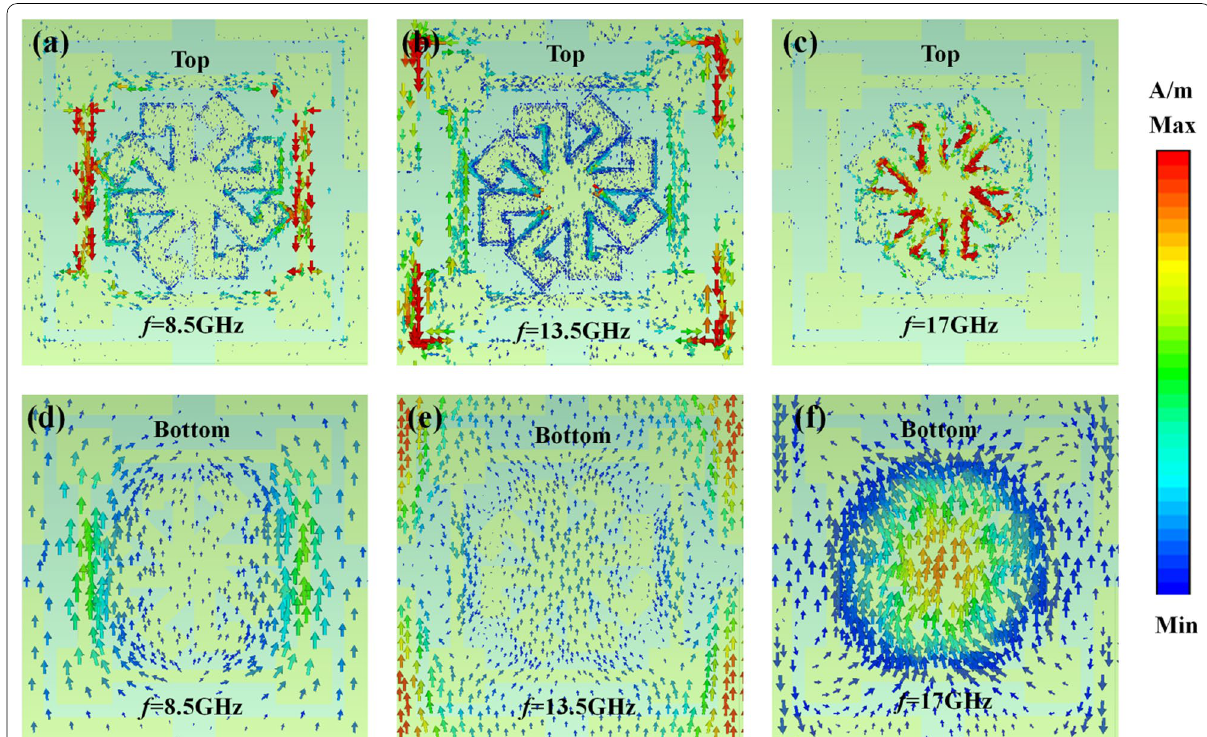
Fig. 4 Simulated surface current distribution on the top patterned layer and bottom ground layer at a , d 8.5, b , e 13.5, and c , f 17